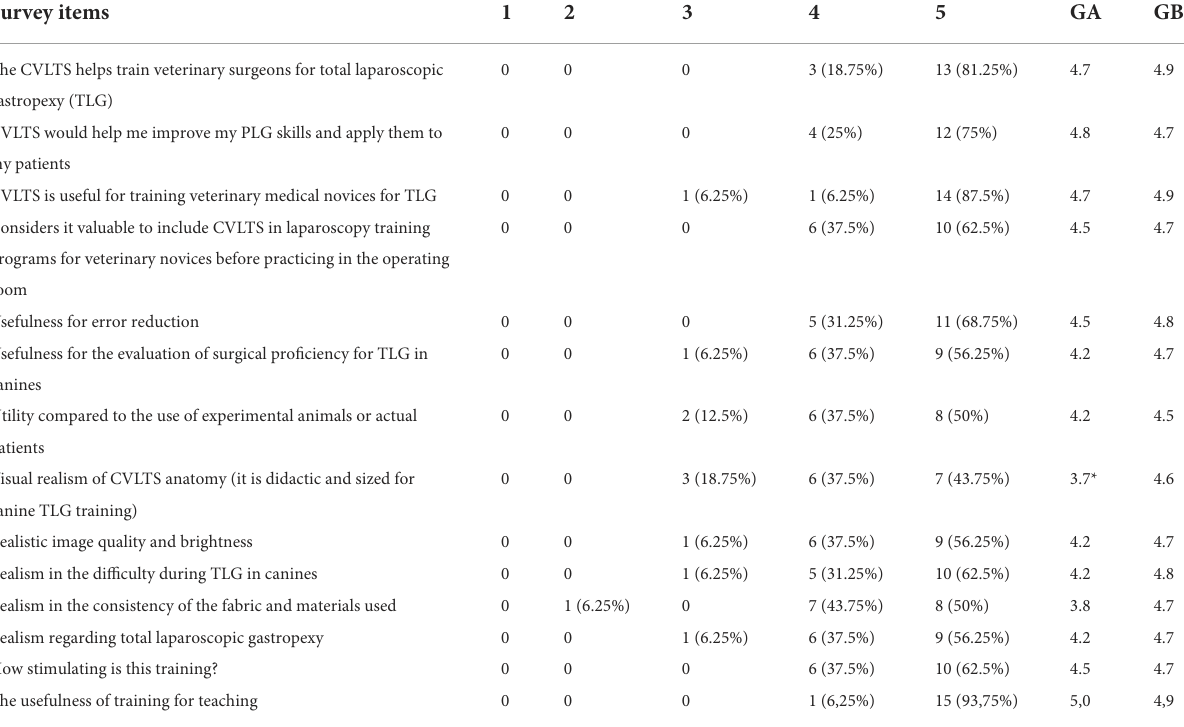
TABLE 1 Total distribution of responses and percentage of responses by